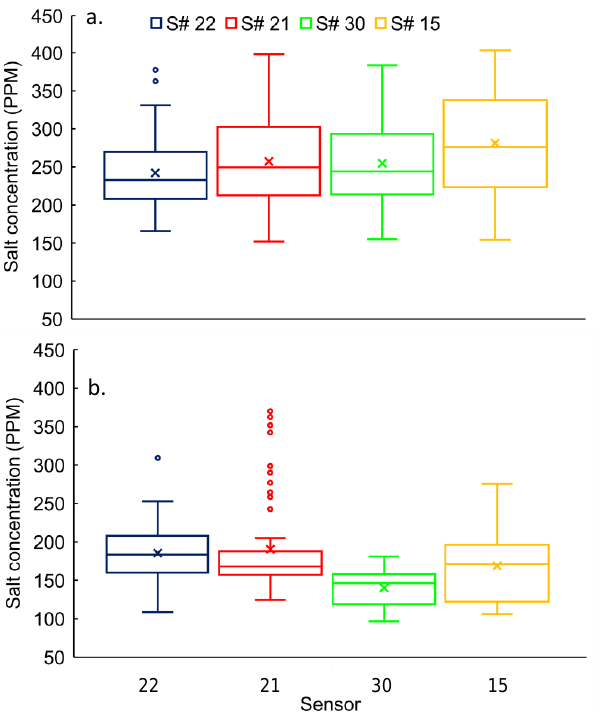
Figure 6. Salt concentrations distribution at stream for S# 22, 21, 30 and 15 (from upstream to downstream) during ( a ) winter and ( b ) spring seasons. For the spring, concentration variability ranged from 20% to 27% for all sensors at